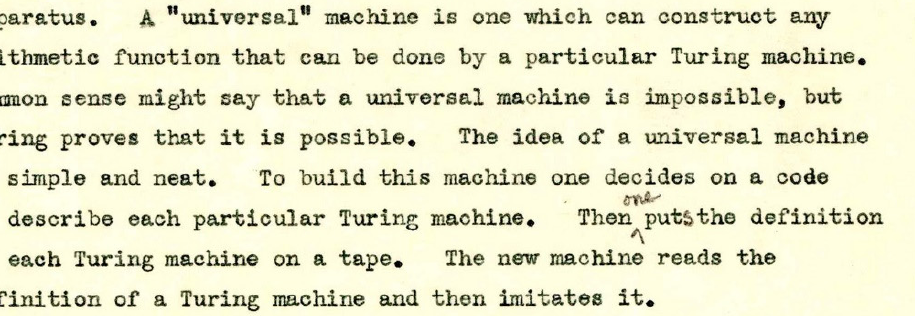
Figure 1. Von Neumann described Turing’s universal machine in his third lecture. Courtesy of the American Philosophical Society.